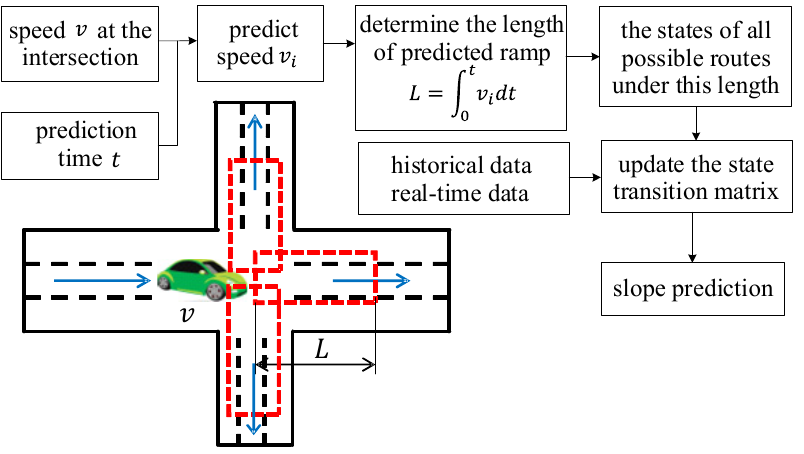
Figure 9. The flow diagram of slope prediction. Ensuring that the road conditions (features) are the same when simulating different driving cycles, the route 4 (green) is taken as an example to predict the slope, which includes two intersections (point A and E). The simulation results are shown in Figure 10.